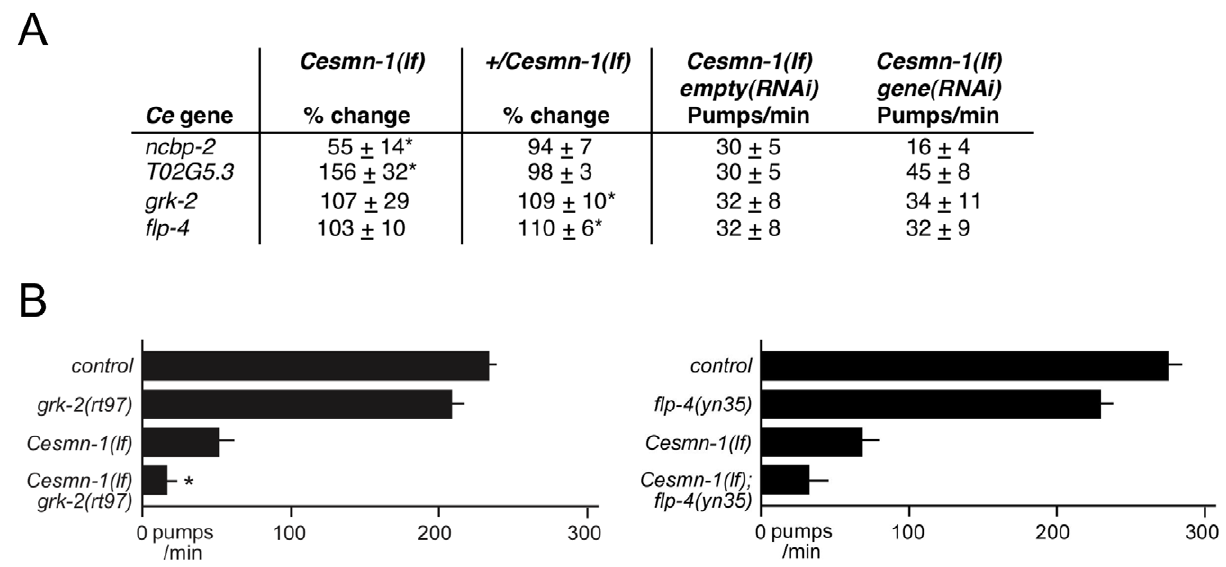
Figure 4. C.elegans RNAi screen identifies conserved SMN modifier genes. A) Four genes were identified as modifiers of Cesmn-1(lf) growth defects in the C. elegans RNAi screen: ncbp-2 , T02G5.3 , grk-2 and flp-4 . The pharyngeal pumping rates of homozygous mutant Cesmn-1(lf) and heterozygous control + /Cesmn-1(lf) animals were determined at day 3 as described in Figure 3. B) For two C. elegans candidate modifier genes, flp-4 and grk-2 , loss of function alleles were available. grk-2(rt97) significantly decreased the pumping rates of Cesmn-1(lf) animals, while flp-4(yn35) lowered Cesmn-1(lf) pumping rates, but did not reach statistical significance (p=0.012 and p=0.236 by two-tailed Mann-Whitney U test, respectively). Pumping rates were determined on day 3 post-hatching; at least 25 animals were scored for each genotype in at least 3 independent trials. Pumping rates reported are the average of all animals in all trials. Significance versus Cesmn-1(lf) is indicated with an asterisk. To control for genetic background, all animals tested were the progeny of animals carrying the balancer chromosome hT2[myo-2p::GFP] ; control animals are hT2/Cesmn-1(lf) siblings.